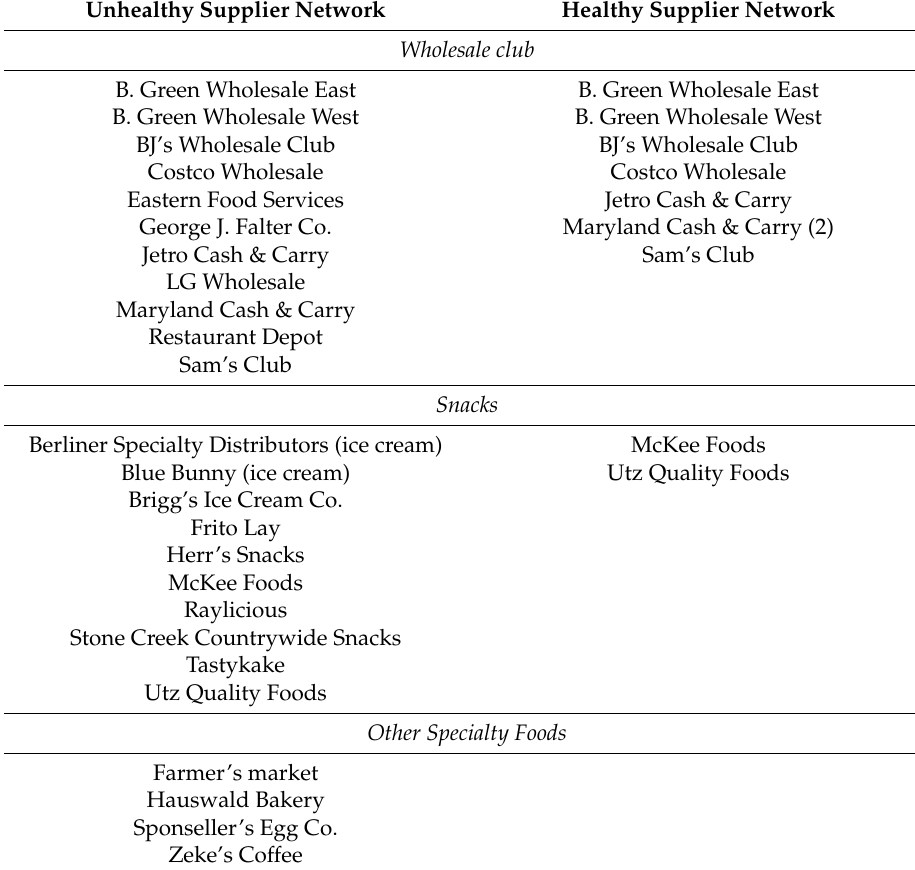
Table 2. Names of suppliers in each supplier category. Reported by corner storeowners in Baltimore City,